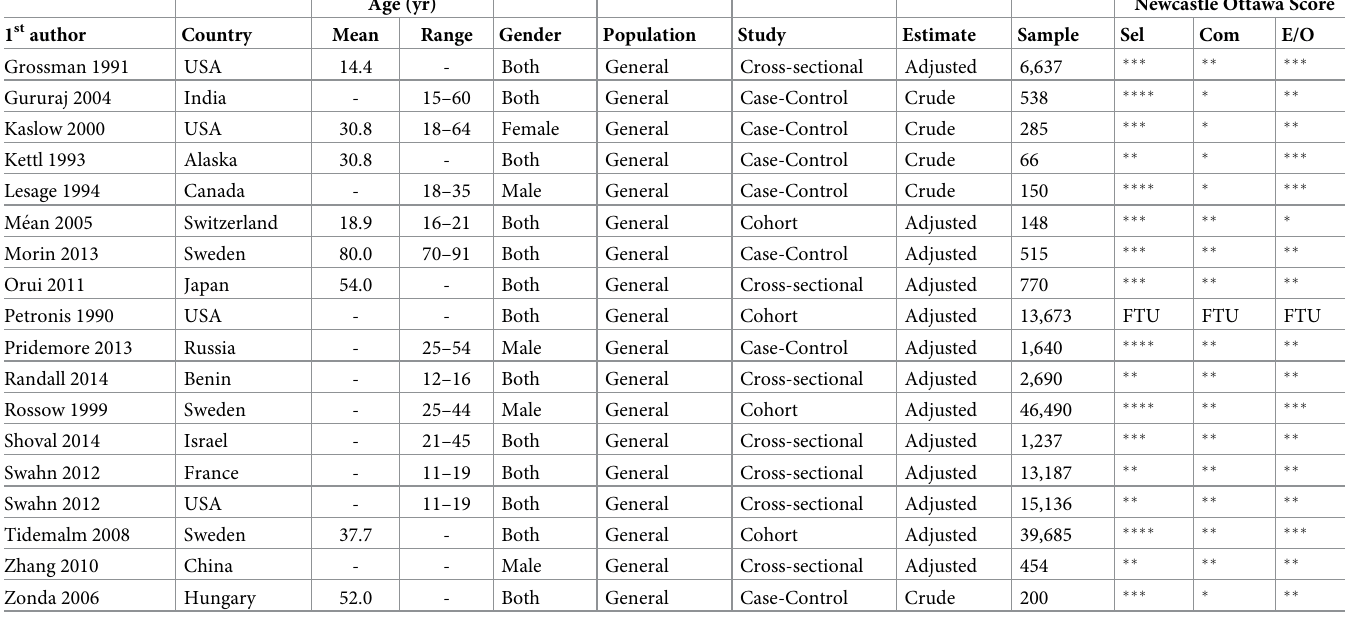
S1 File. Characteristics of the excluded studies. S2 File. Dataset underlying the